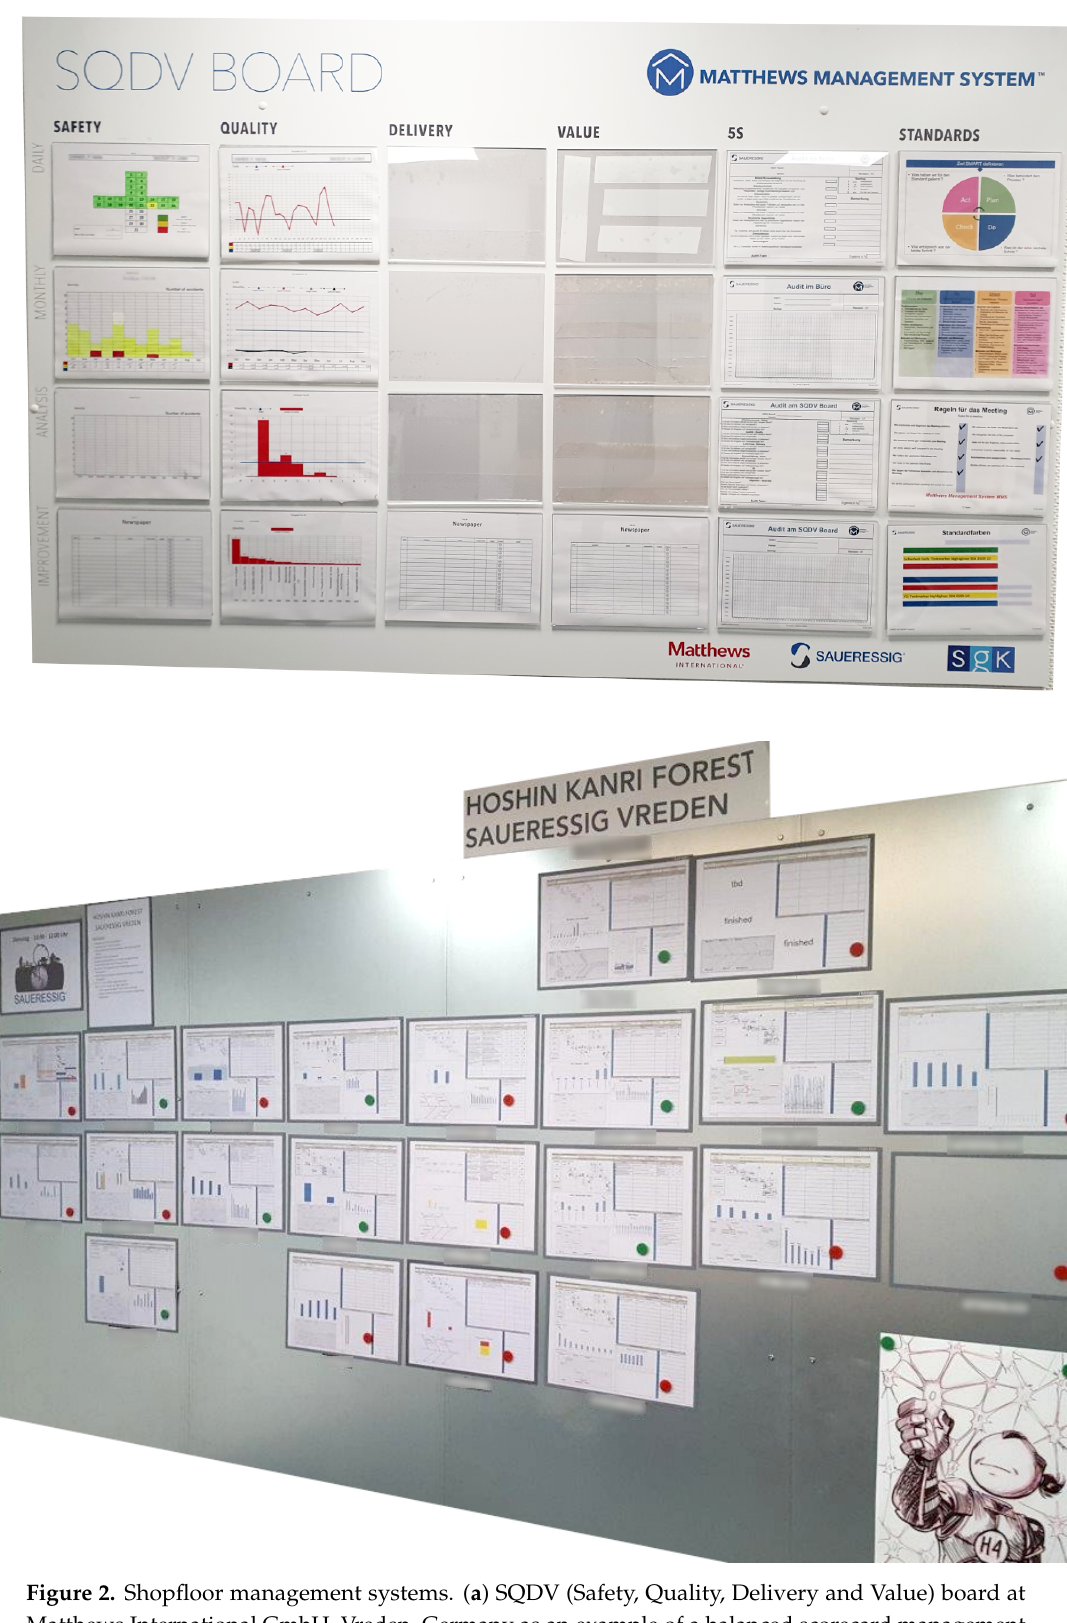
Figure 2. Shopfloor management systems. ( a ) SQDV (Safety, Quality, Delivery and Value) board at Matthews International GmbH, Vreden, Germany as an example of a balanced scorecard management system [44]. ( b ) Hoshin Kanri TREE [45] at Matthews International GmbH, Vreden, Germany. Process owner names are blurred out for privacy